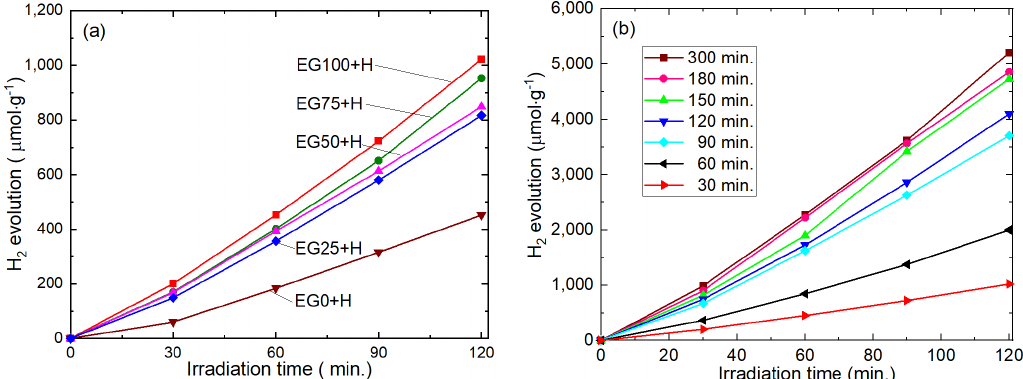
Figure 6. Dependence of H 2 evolution on ( a ) the amounts of EG to water during CdS nanocomposite synthesis and ( b ) the light irradiation time of Pt photodepostion on CdS nanocomposite.